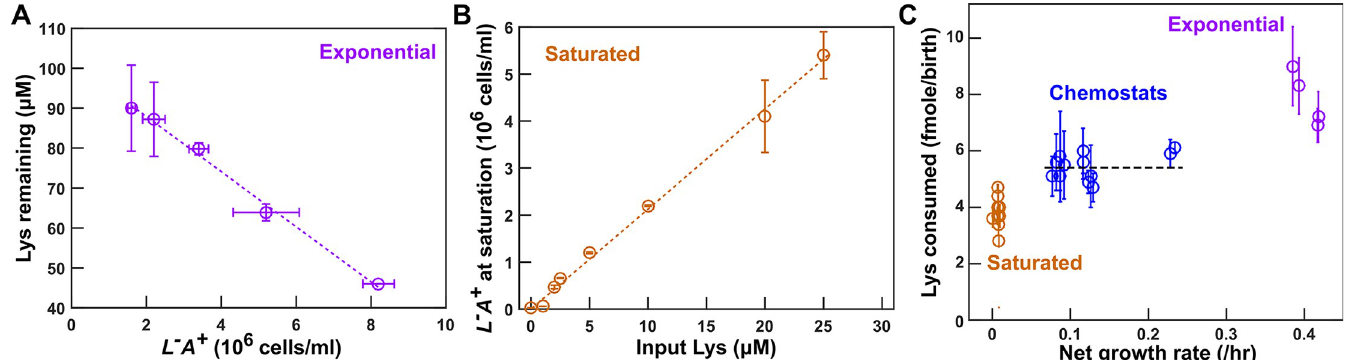
Fig 4. Metabolite consumption is sensitive to the environment. ( A ) Consumption in excess lysine. L − A + population density and lysine concentration remaining in the medium were measured over time (Methods, “Measuring consumption in batch cultures”). Consumption per birth was calculated from the slope of the lavender line. ( B ) Consumption in cultures grown to saturation. L − A + cells were inoculated into SD supplemented with various concentrations of lysine. After cultures had reached saturation, total cell densities were measured by flow cytometry. Lysine consumed per birth was quantified from 1/(slope of the orange line). This value was used in Models i and ii. ( C ) Consumption per birth in different environments. Lysine consumption was measured in lysine-limited chemostats at various doubling times (Methods, “Quantifying phenotypes in chemostats,” and Eq 12), and data were jittered slightly along the x axis to facilitate visualization. For chemostat measurements, error bars represent 2 standard deviations caused by fluctuations in steady-state population density. For exponential and saturation consumption, error bars mark 2 SEMs for slope estimation. The black dashed line marks the average lysine consumption per L − A + birth in chemostats (Table 1; S5 Table), which we used in Model iii. All plotted data can be found in S4 Data. Lys, lysine; SD, Synthetic Dextrose minimal medium; SEM, standard error of the mean.